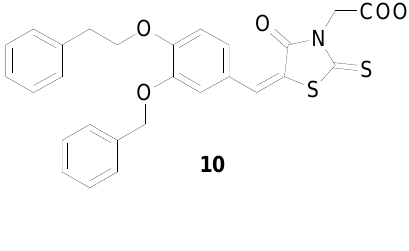
Figure 3. Structure of compound 10 , PMT1 inhibitor.